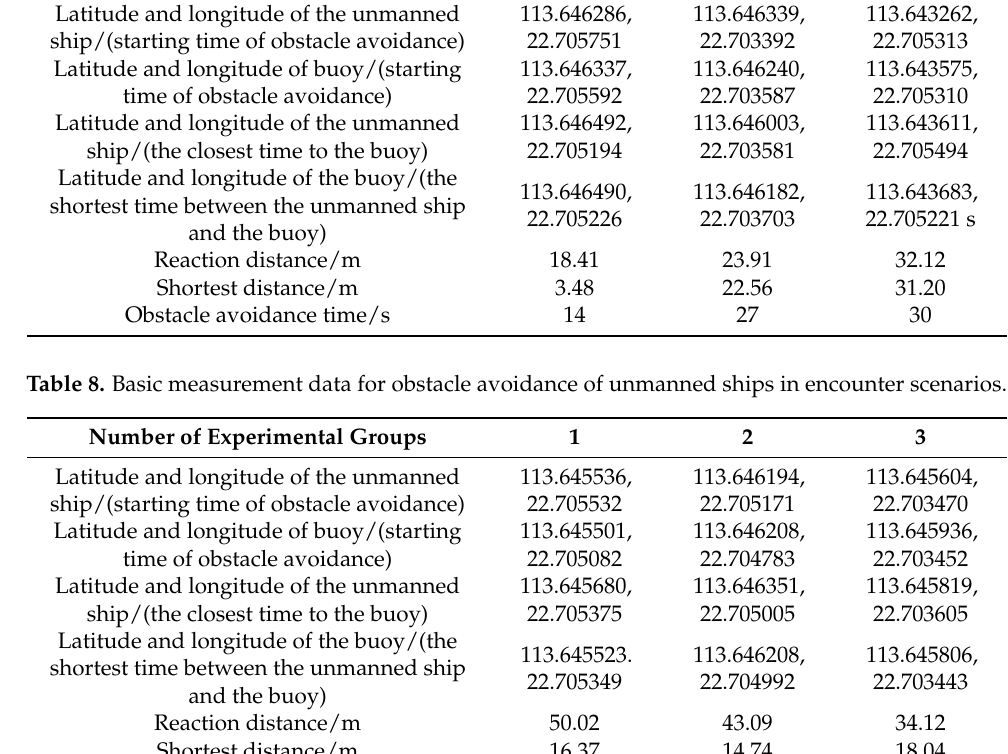
Table 7. Basic measurement data for obstacle avoidance of unmanned ships in chasing scenes. Number of Experimental Groups